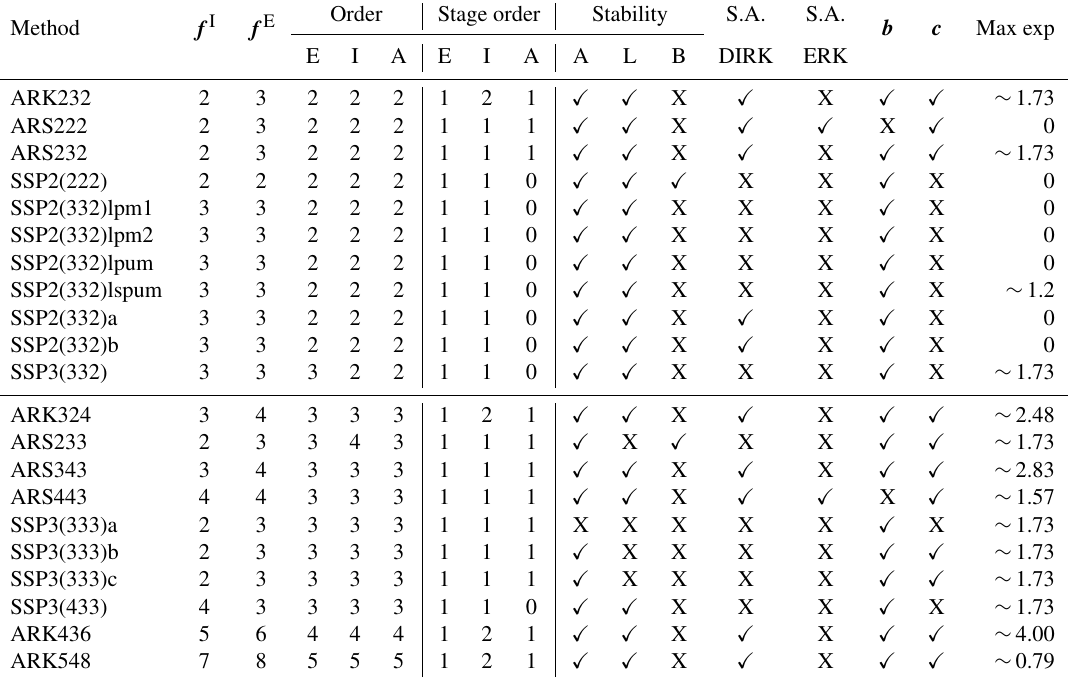
Table A1. Properties for each of the ARK methods used in this paper. The column headings are described in the above text. Order Stage order Stability S.A. S.A. Method f I f E ARK232